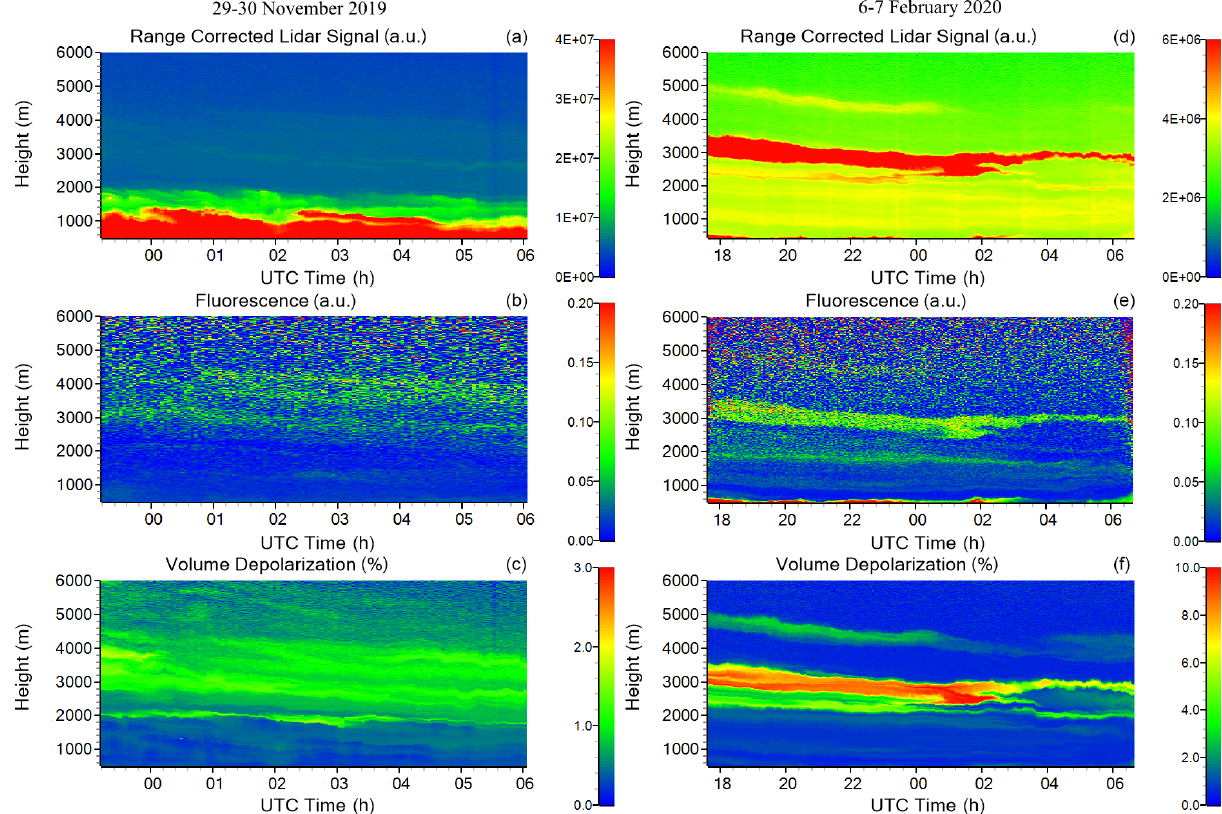
Figure 2. The range-corrected lidar signal at 1064nm, fluorescence backscattering and volume depolarization ratio δ 1064 measured at Lille